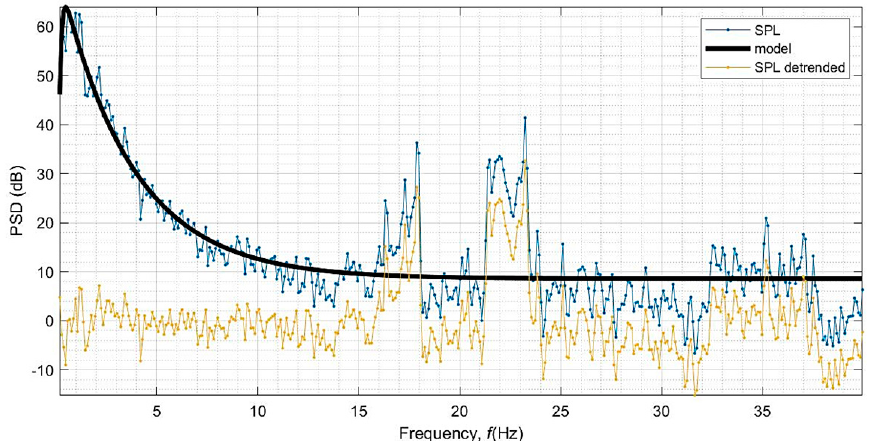
Figure 14. Example of a PSD distribution from a one-minute SPL -referenced signal, trend line calculated using the model and the corresponding detrended signal. The frequency range was bee reduced down to 40 Hz.